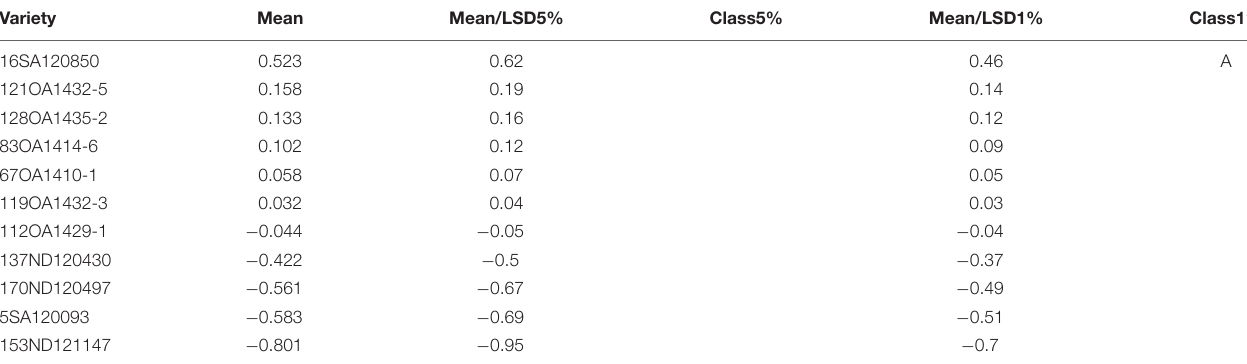
TABLE 10 | Effects of salt, alkali stresses on the plant height of tolerant and sensitive oat genotypes in experiment 3. Variety